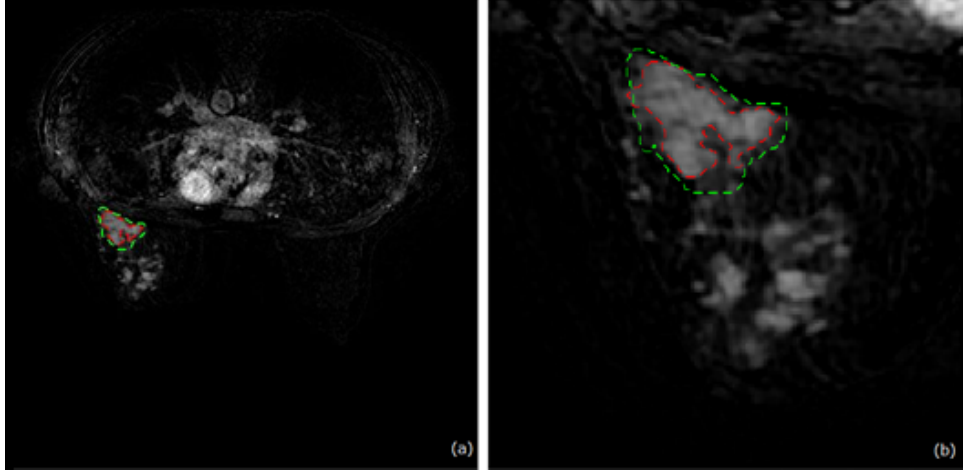
Figure 14. Case with a blurred boundary lesion: ( a ) entire axial DCE-MRI slice; ( b ) crop of the slice shown in ( a ). Comparison between manual ground-truth (green) and automated segmentation